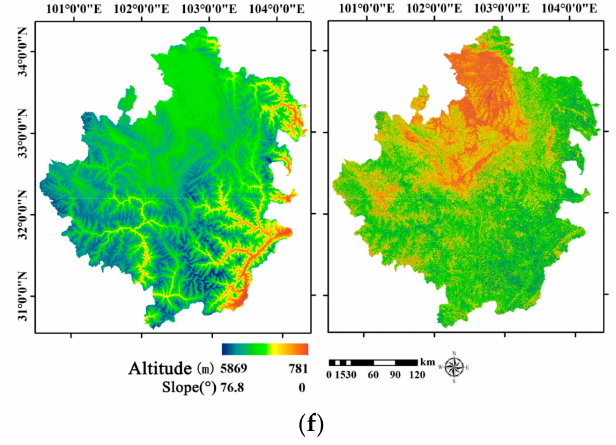
Figure 5. Spatial distribution map of sensitivity indexes. ( a ) soil erosion intensity, ( b ) proportion of sloping farmland, ( c ) SHEI, ( d ) the accumulated temperature is greater than or equal to 10 degrees, ( e ) average annual precipitation, and ( f ) topographical